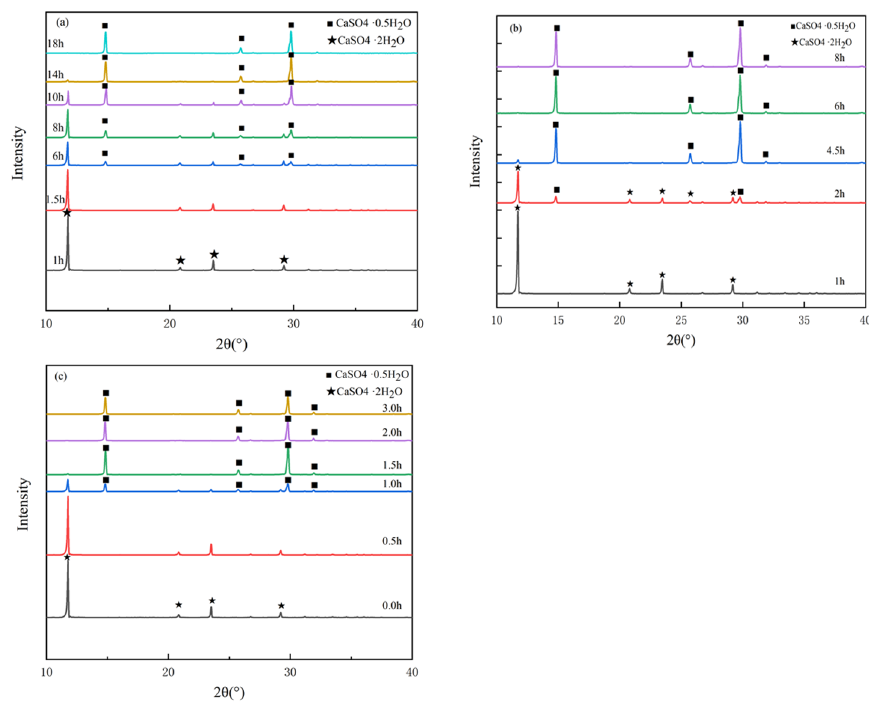
Figure 1 . XRD patterns of samples synthesized at different temperatures ( a ) 92 °C, ( b ) 95 °C and ( c ) 98